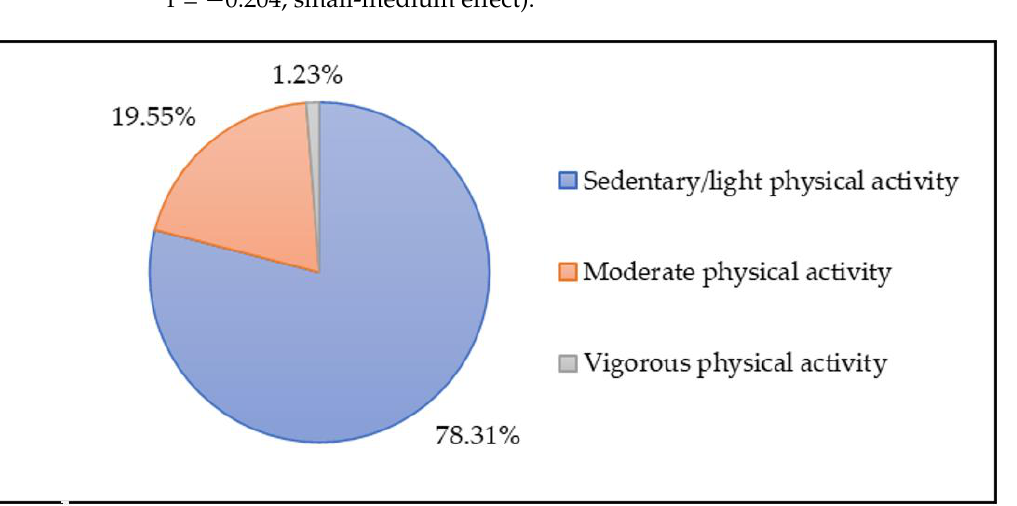
Figure 1. Percentage of recorded time engaged in different levels of activity, from accelerometers. There were significant correlations between kCal/hour and light ( p < 0.001, r = −0.688; object control) and activity (sedentary/light, moderate, vigorous). There was, however, a correlation between locomotor standard scores and sedentary activity ( p = 0.014, r =